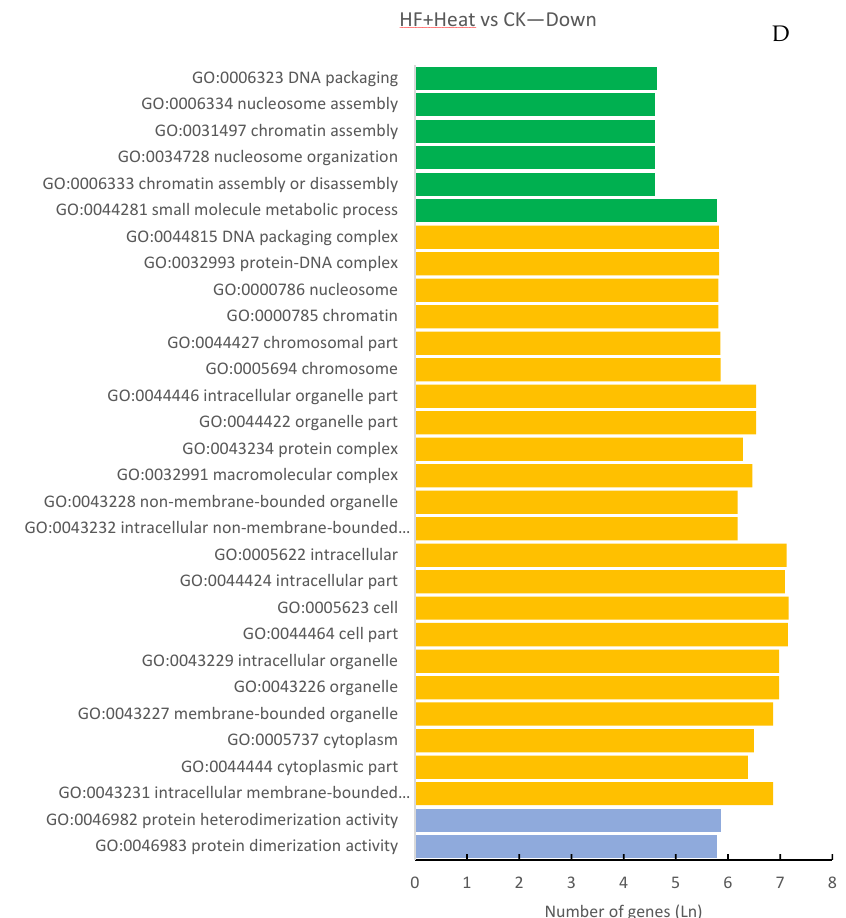
Figure 2. Top 30 GO terms up- or down-enriched by heat stress and the combination of heat stress and HF infestation. X -axis: Natural logarithm of the number of DEGs. Y -axis: GO number and term. ( A ): Up-enriched by heat stress. ( B ): Down-enriched by heat stress. ( C ): Up-enriched by the combination of heat stress and HF infestation. ( D ): Down-enriched by the combination of heat stress and HF infestation. Green color: Biological process; Orange color: Cellular component; Grey color: Molecular function.